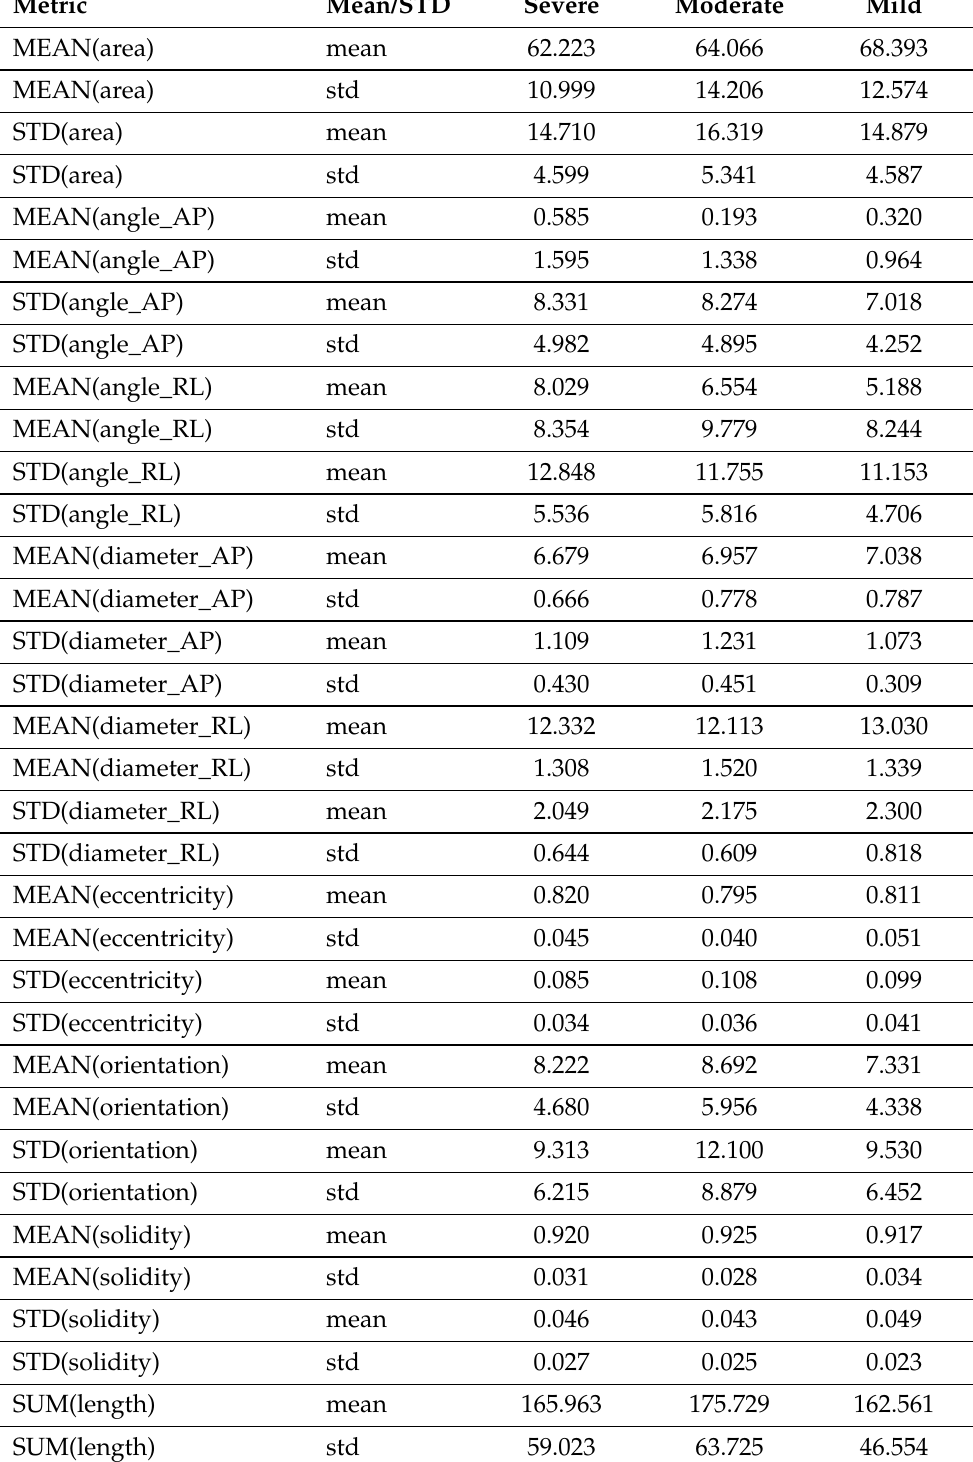
Table 2. Variation of metric measures across mJOA severity classes in the manually segmented subset, summarized. Please note that the ’Mean/STD’ column denotes whether the metric used was the mean of the ’Metric’ column or the ’Standard Deviation’ of said ’Metric’ column. A visualized version of this data, alongside statistical assessments, can be found in Figure